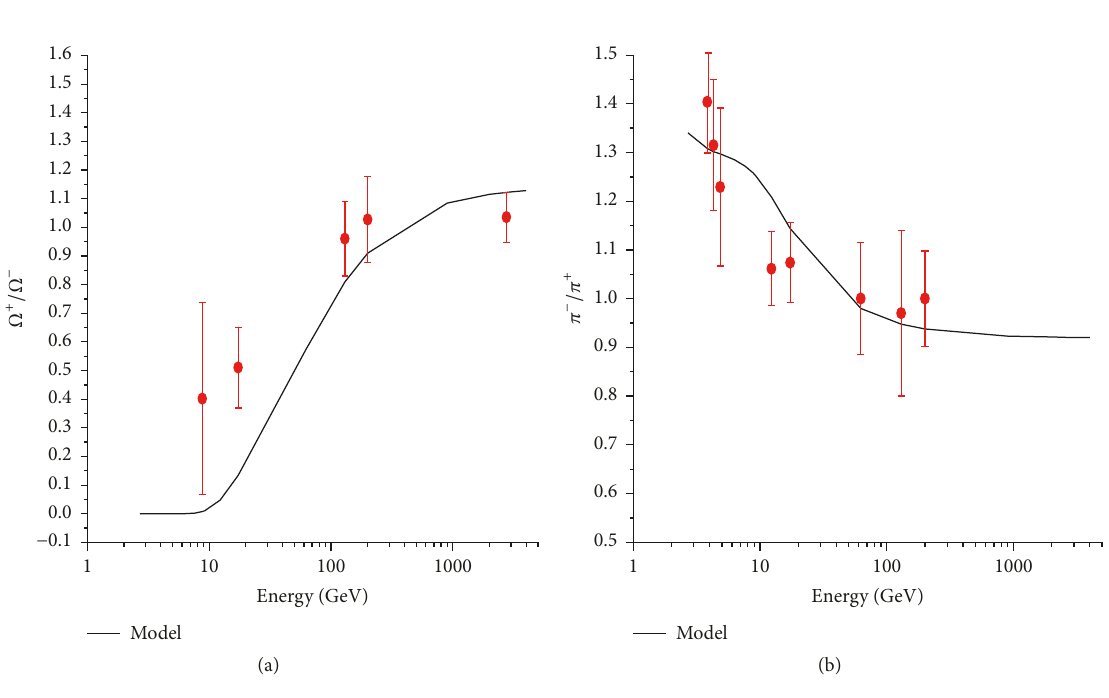
Figure 4: Energy dependence of Ω/Ω (a) and 𝜋 − /𝜋 + (b)